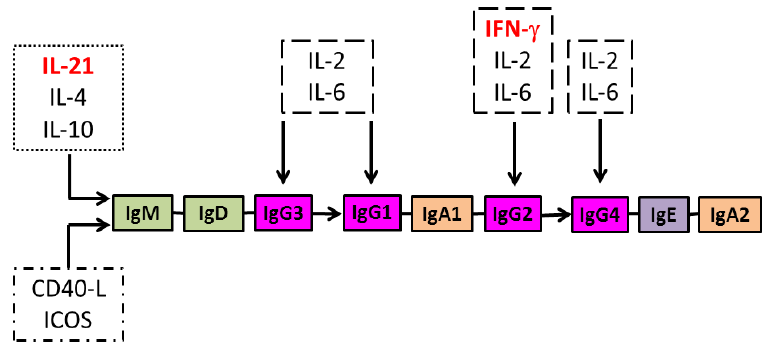
Figure 1. Isotype diversification of an IgG antibody response. IgG antibody isotype switching during B-cell differentiation in germinal centres results from class switch recombination of immunoglobulin heavy chain genes from “downstream” (IgG3 and IgG1) to “upstream” (IgG2 and IgG4) isotypes regulated by co-stimulatory molecules (CD40L and inducible co-stimulator (ICOS)) and cytokines (IL-4, IL-10 and IL-21). Pro-inflammatory cytokines (IL-2, IL-6 and IFN-  ) enhance immunoglobulin production with IFN-  particularly increasing IgG2 production. CD4 + T-cell production of both IL-21 and IFN-  is impaired by HIV